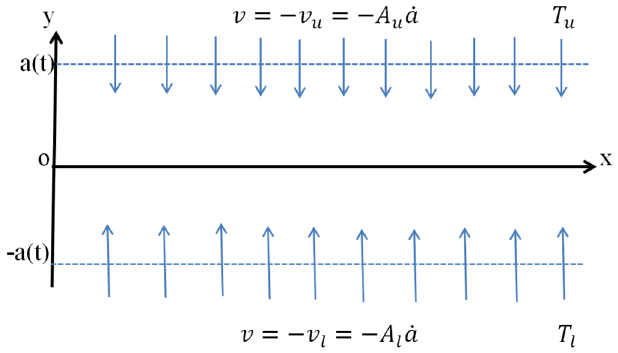
Figure 1. Geometry of the